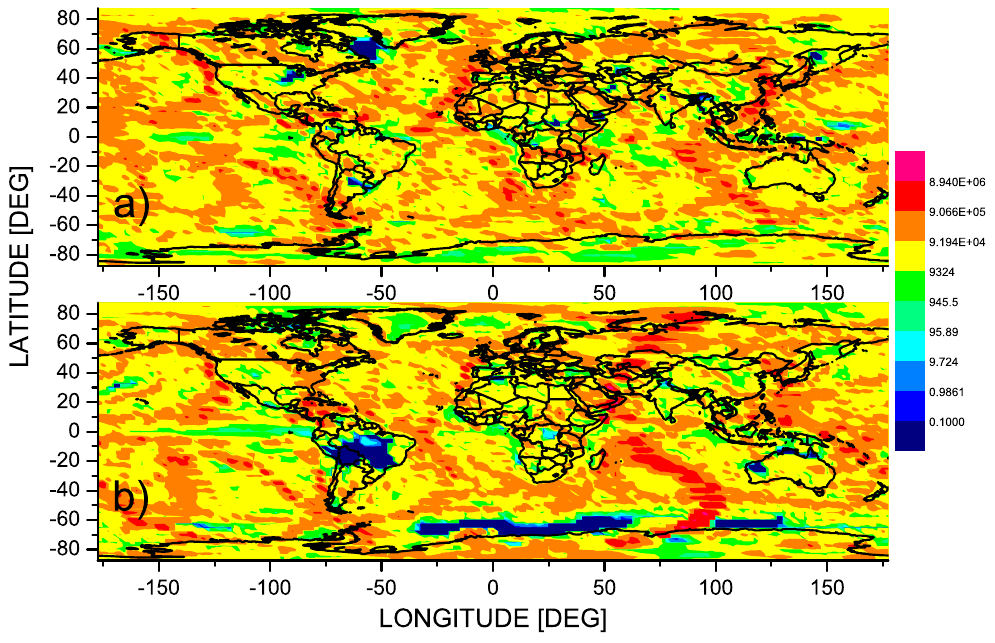
Fig. 12. Betweenness centrality for SATA climate networks with density % = 0 . 005 obtained by uniform thresholding of the absolute correlations for negative (a) and positive (b) NAO index.